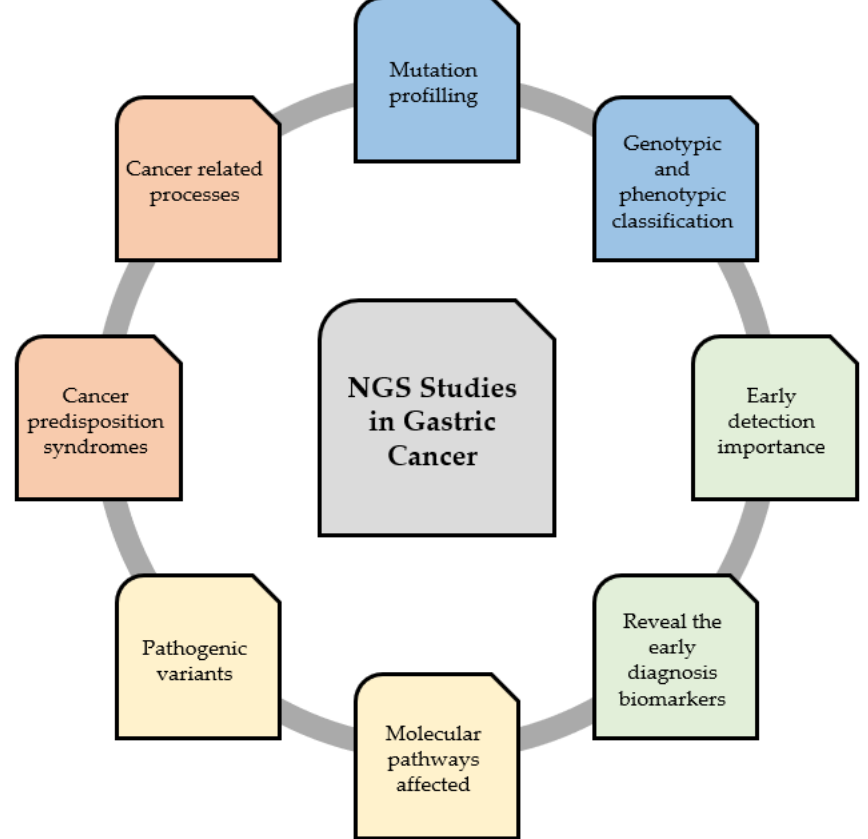
Figure 2. Next-generation sequencing (NGS) as a useful tool for studying the development of gastric carcinoma in a high-throughput carcinoma in a high-throughput way.